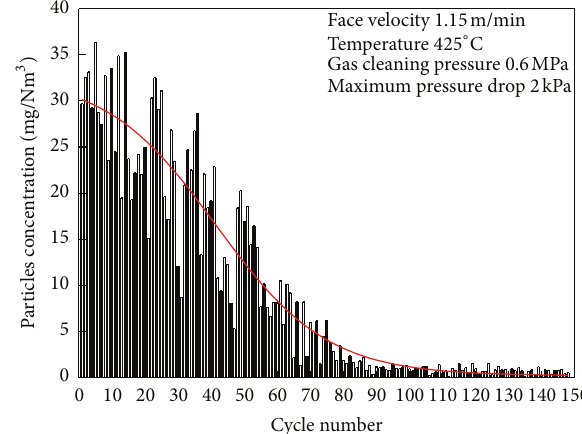
Figure 11: Typical particles emission profile during